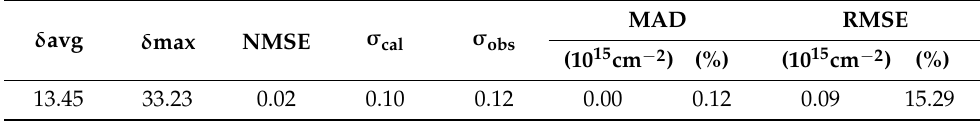
Table 4. The average and maximum of the absolute relative bias ( δ avg and δ max (%)), NMSE, and standard deviations of calculated and observed NO 2 VCDs ( σ cal and σ obs, respectively). The mean bias errors (MAD, MJ m − 2 and %) and the root mean square errors (RMSE, MJ m − 2 and %) (n = 216). MAD RMSE δ avg δ max NMSE σ cal σ obs (10 15 cm − 2 ) (%) (10 15 cm − 2 ) (%) 13.45 33.23 0.02 0.10 0.12 0.00 0.12 0.09